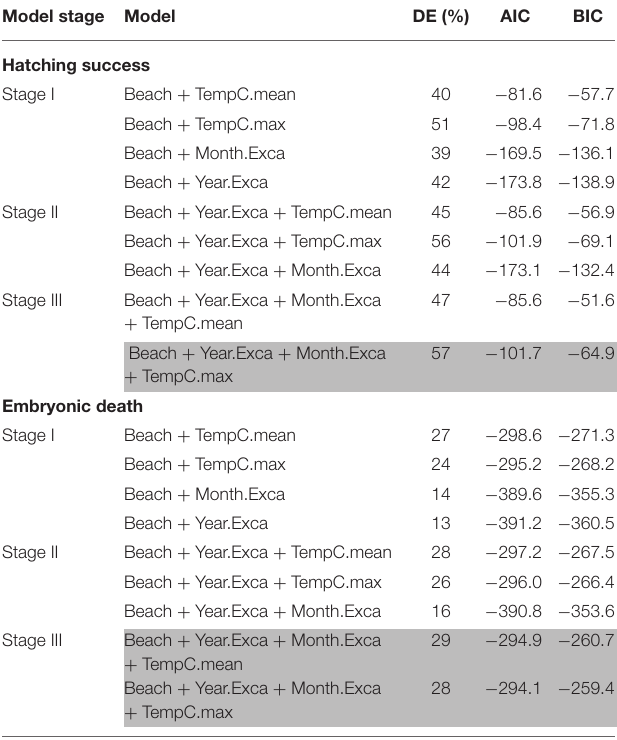
TABLE 4 | Generalized additive models (GAMs) exploring the influence of nest temperatures (mean and maximum during incubation) on hatching success and embryonic death for green turtle ( Chelonia mydas ) nests in Saipan,